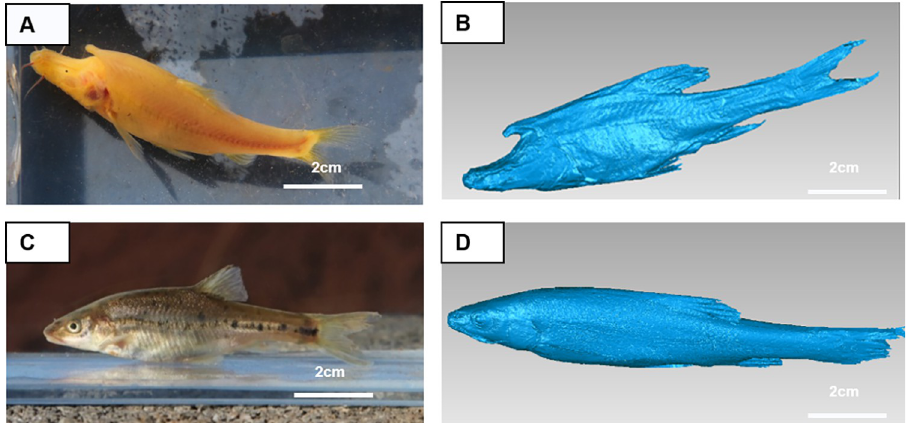
Fig 1. S . rhinocerous and S . angustiporus individuals. (A) A S . rhinocerous individual, and (B) a 3-D digital model of a S . rhinocerous specimen. (C) A S . angustiporus individual, and (D) a 3-D digital model of a S . angustiporus